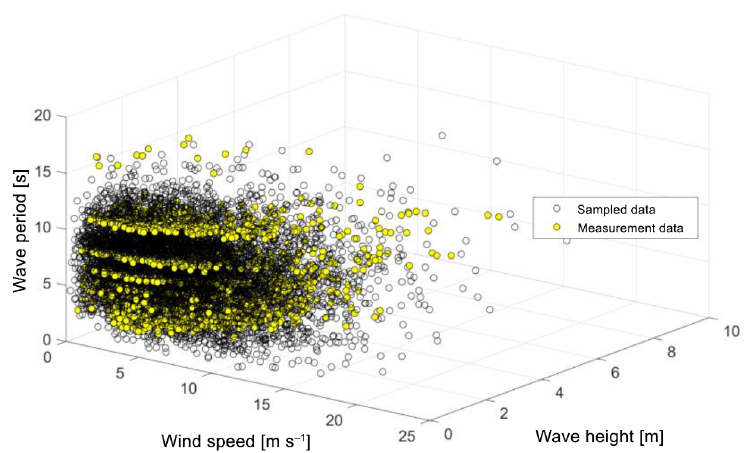
Figure 5. Sampled environmental conditions and baseline measurements.